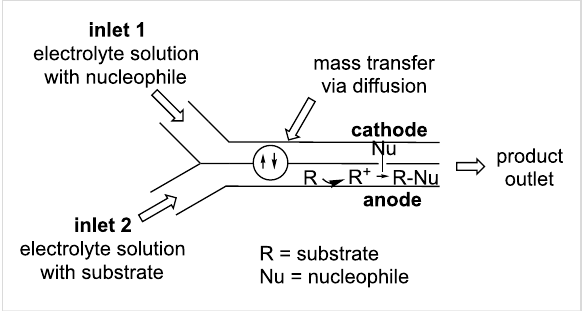
Figure 2: Example of a parallel laminar flow set-up. Figure redrawn from reference